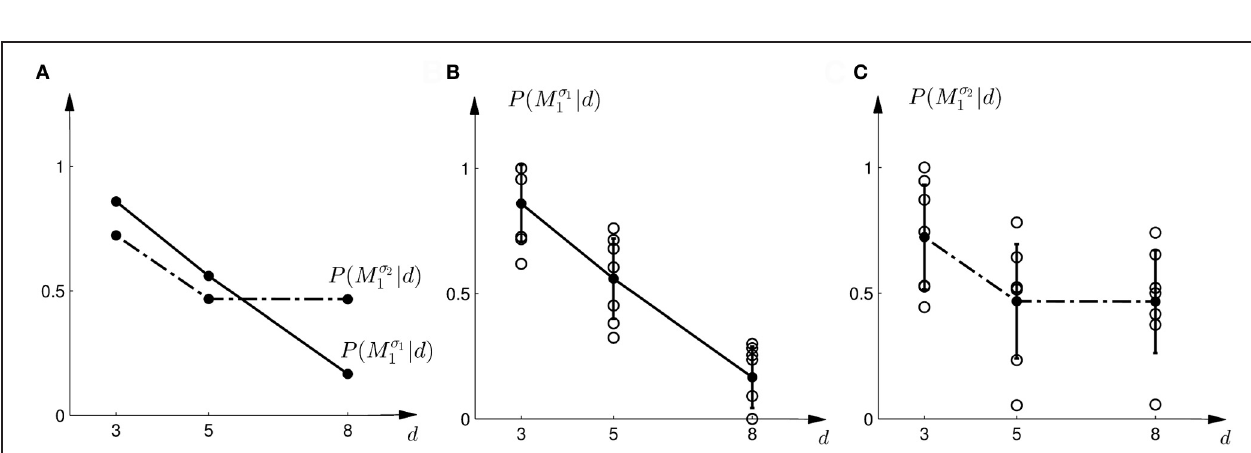
FIGURE 2 | Prior distributions for the horizontal shift s . (A) Shows the two prior distributions induced by model M σ 1 1 (Gaussian distribution with σ 1 = 1, solid line) and M 2 (mixture of two Gaussians, dashed line) in the first